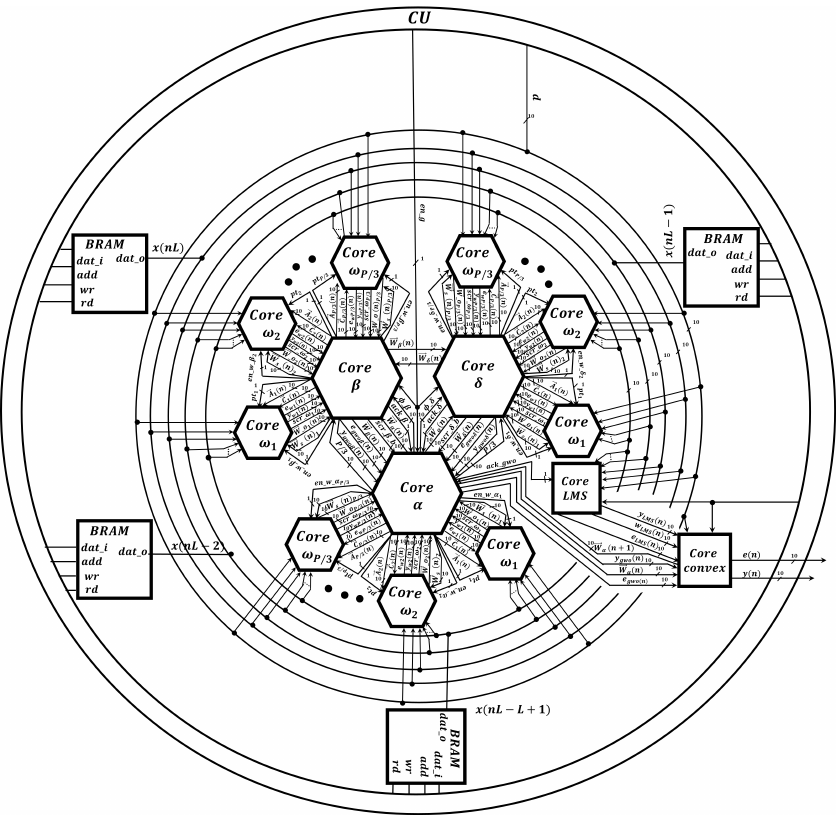
Figure 12. Scheme of the proposed AEC neural processor.